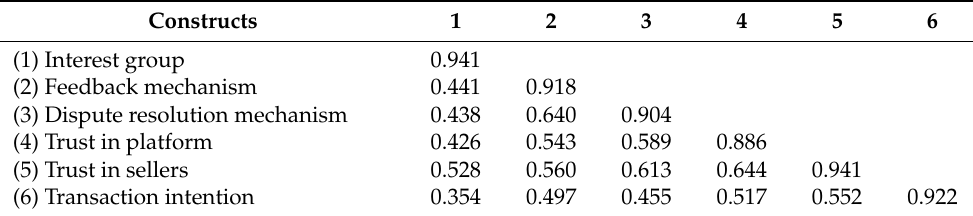
Table 3. Discriminant validity of